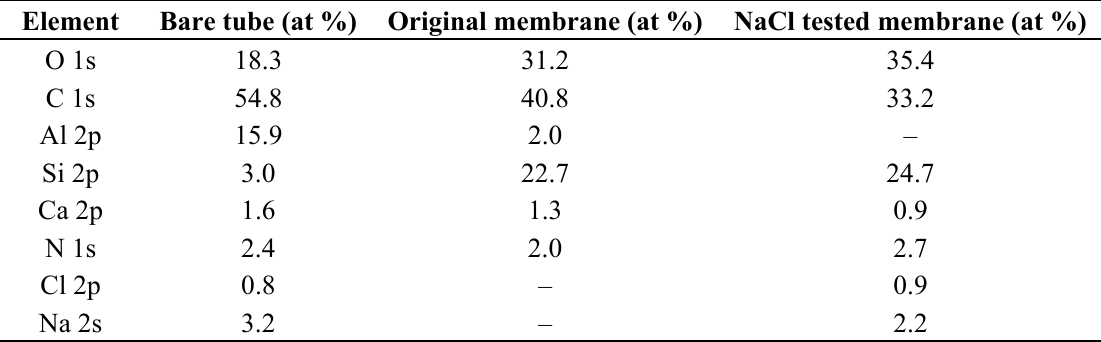
Table 3. XPS analysis of elements on the bare α -Al desalination tested zeolite